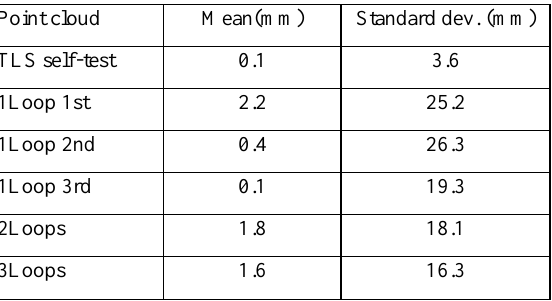
Table 3: Points to plane based error analysis of point